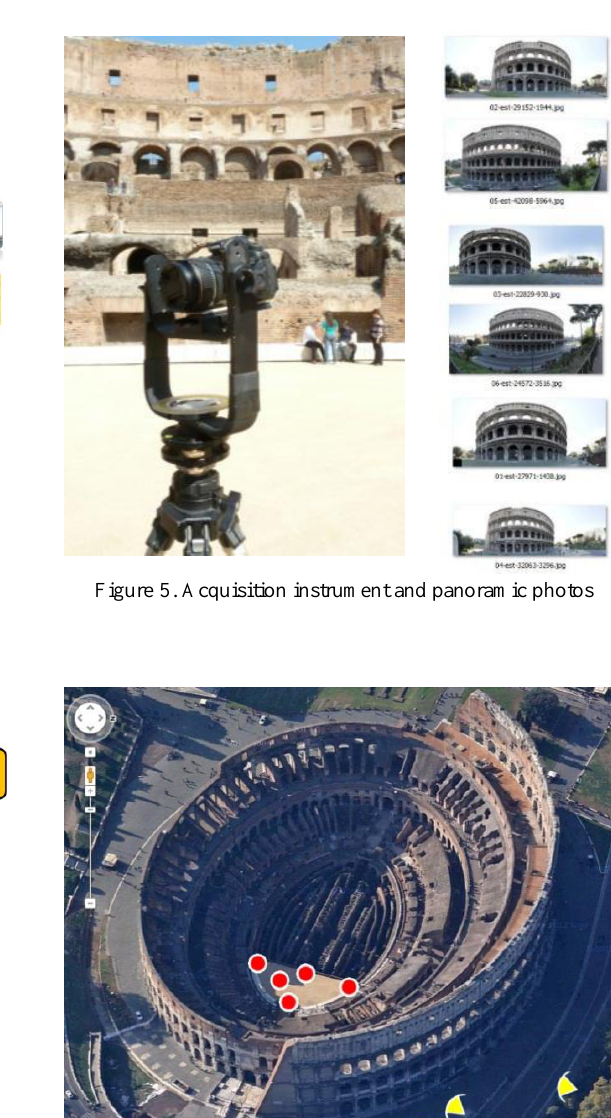
In Figure 4, the flowchart points out the main steps of the developed workflow: it starts from panoramic images and integrate the two different 3D restitution techniques (MISP and SfM) into an Image-based Modeling solution.